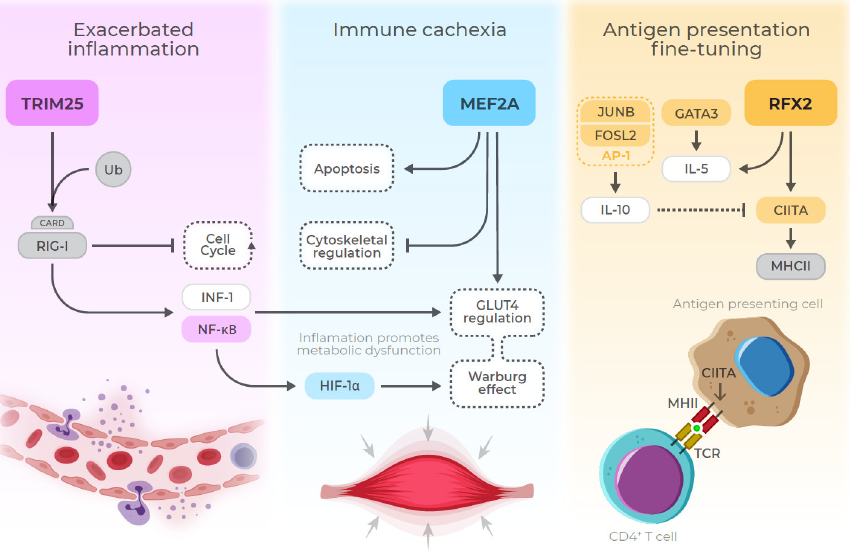
Figure 7. Main findings summary. This figure summarizes the main findings regarding the three top different master regulators: TRIM25 , MEF2A , and RFX2 .